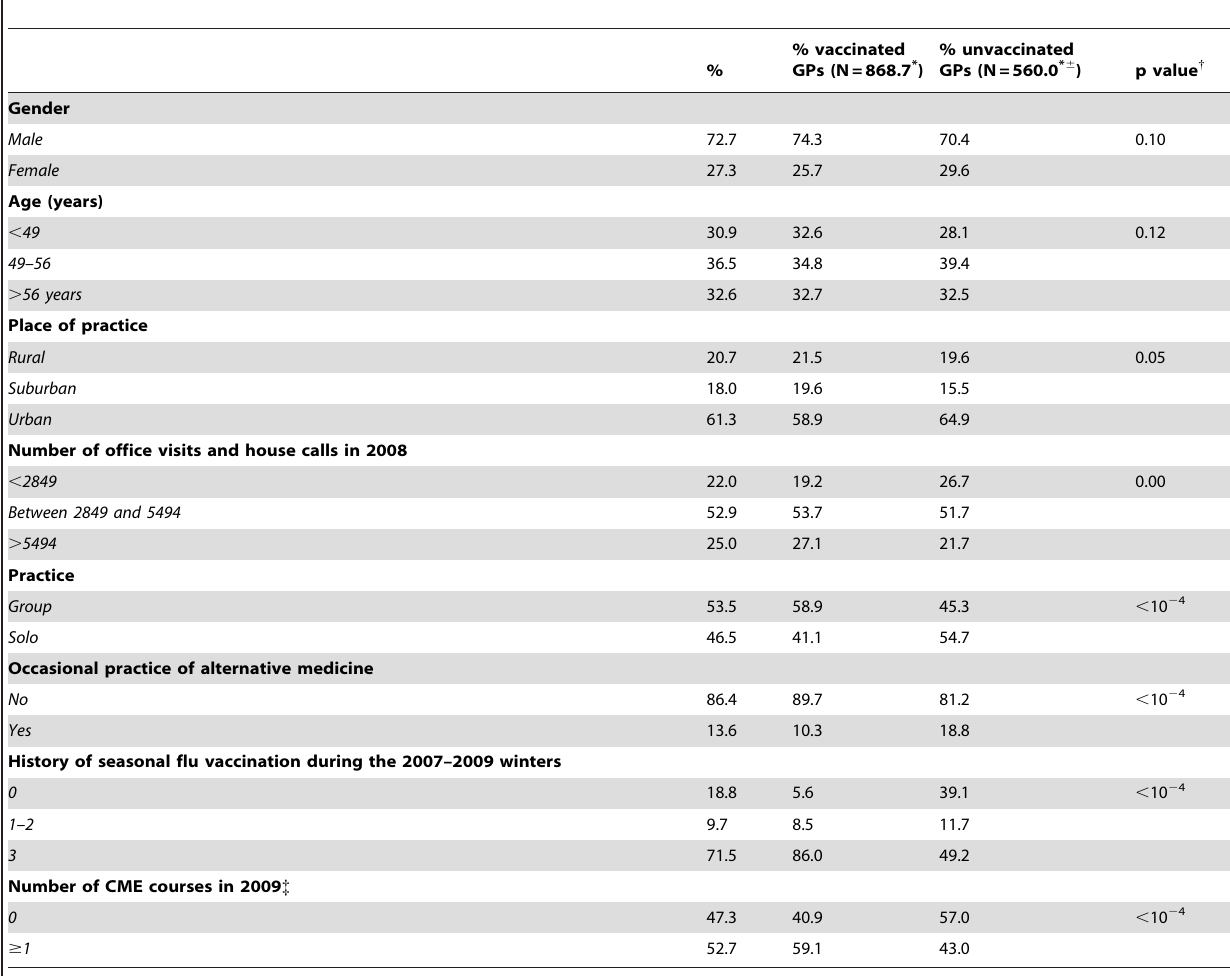
Table 1. Social, demographic, and professional characteristics of GPs according to their vaccination status for A/H1N1 flu (French nationwide panel of general practitioners, weighted data,